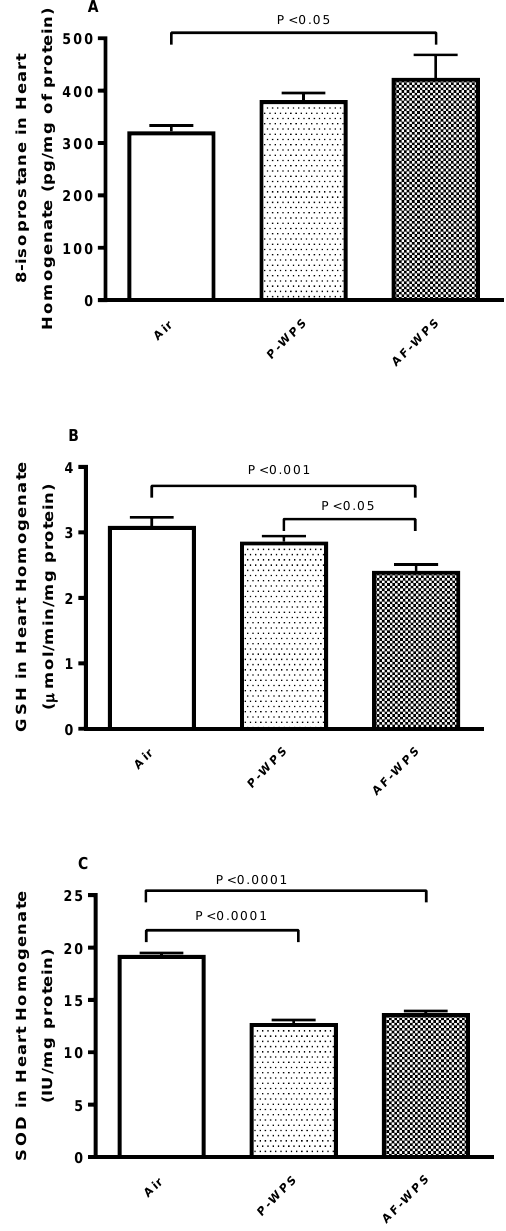
Figure 6. Effects of plain water-pipe smoke (P-WPS) or apple-flavoured (AF)-WPS on markers of oxidative stress. Heart homogenate levels of 8-isoprostane ( A ), reduced glutathione (GSH, B) and superoxide dismutase (SOD, C ) at the end of 1 mo exposure period to either air or P-WPS or AF-WPS. Data are mean ± SEM (n = 6–8); one-way ANOVA followed by Holm–Sidak’s multiple comparison test.